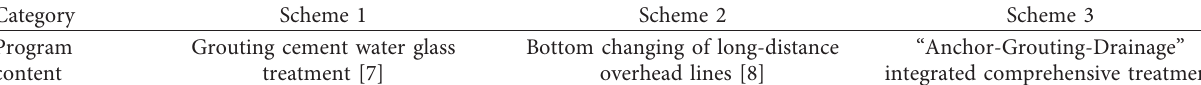
Table 1: Comparison of maintenance and renovation